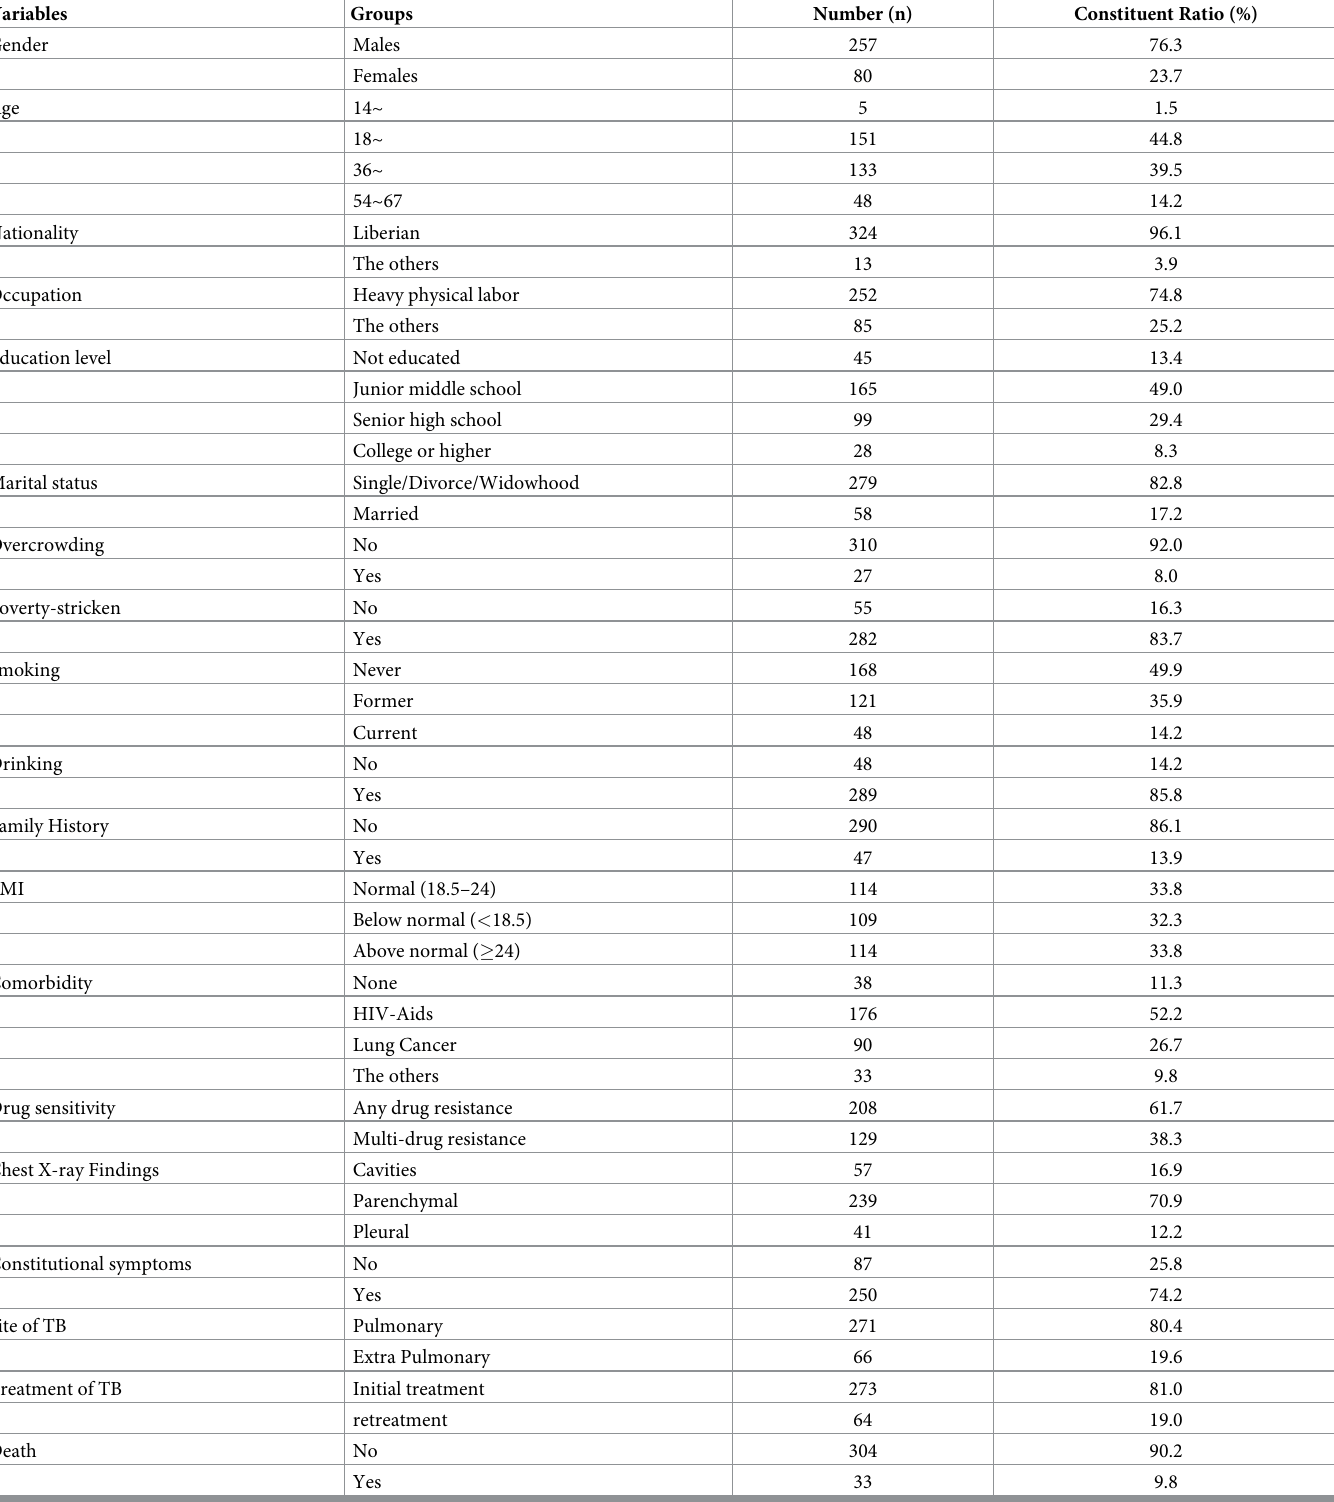
Table 1. Demographic and clinic characteristics of TB patients in Liberian (n =